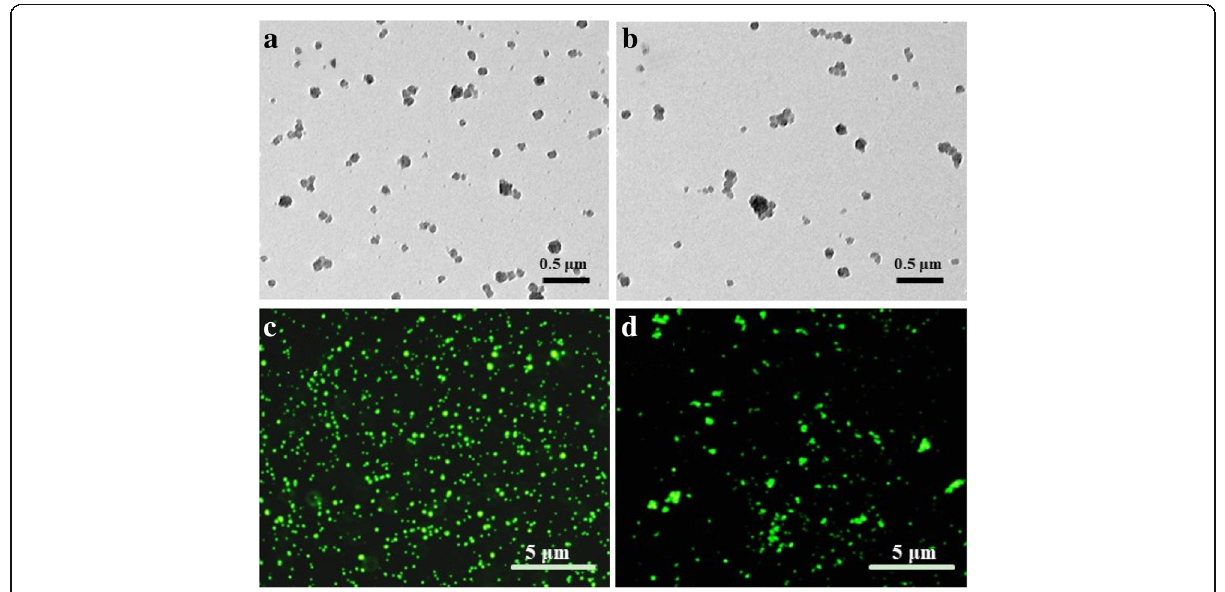
Fig. 1 Images of Apt-GS ( a , c ) and Apt-GS/siRNA nanogels ( b , d ). a , b TEM images. Scale bars represent 0.5 μ m. c , d Fluorescent images. Scale bars represent 5 μ m